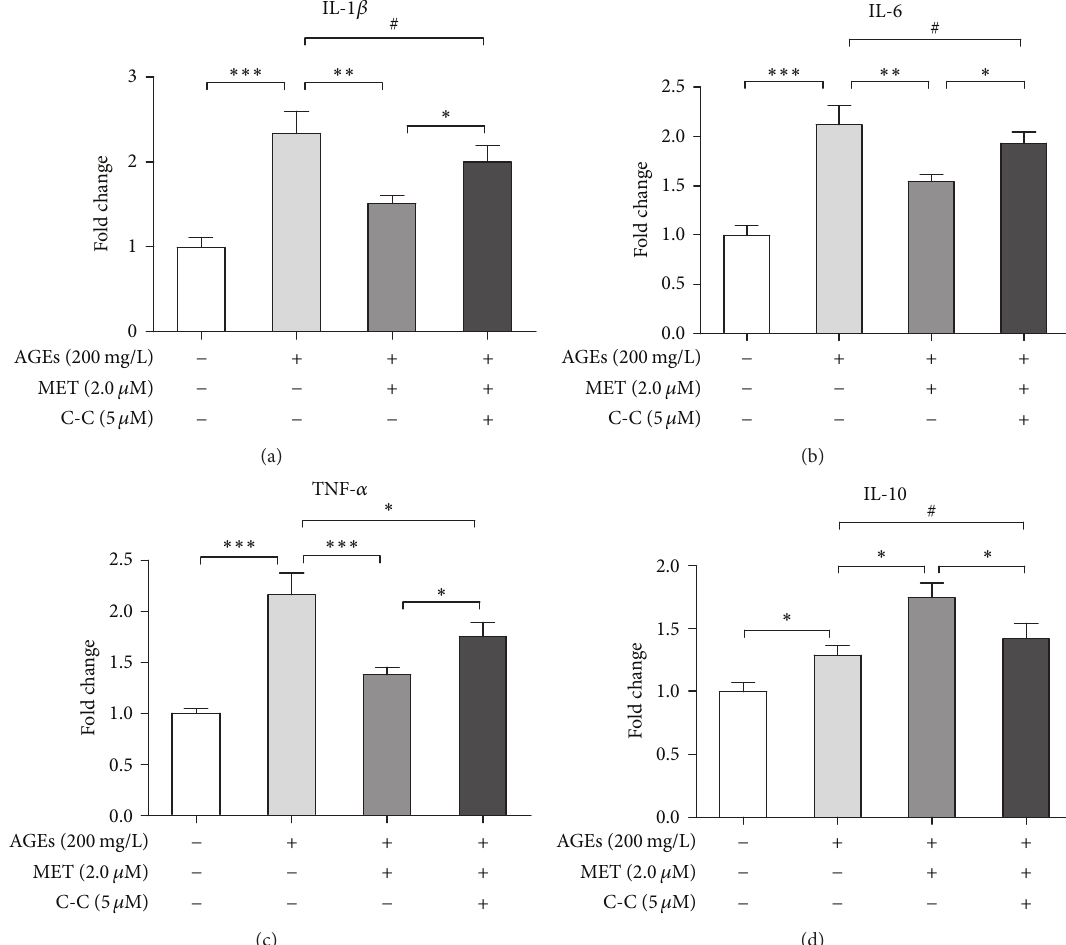
Figure5:Metformin’sinhibitiononAGEs-inducedinflammatoryresponseisAMPKdependent.BMDMsweredividedinto4groups:control, AGEs, AGEs + MET, and AGEs + MET + CC group. In AGEs group, cells were cultured with AGEs at 200mg/L for 60 min; in AGEs + MET group, cells were pretreated with metformin for 60 min and then cultured with AGEs at 200 mg/L for 60 min; in AGEs + MET + C-C group, cells were pretreated with Compound C, an AMPK inhibitor, at 5 𝜇 M for 60 min, and then they were treated with metformin at 2.0 𝜇 M for 60 min followed by AGEs at 200 mg/L for 60min; in control group, cells were cultured with BSA at 200 mg/L for 60 min. RNA then was extracted, and mRNA levels of IL-1 𝛽 (a), IL-6 (b), TNF- 𝛼 (c), and IL-10 (d) were measured by real-time PCR. Bar graphs represent the results (mean ± SD) of three independent experiments. One-way ANOVA was applied and all the overall ANOVA was significant. # 𝑝 > 0.05 ; ∗ 𝑝 < 0.05 ; ∗∗ 𝑝 < 0.01 ; and ∗∗∗ 𝑝 < 0.001 when compared between selected